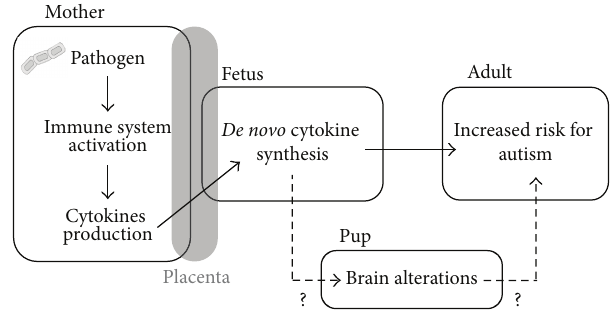
Figure 1: Association between prenatal infection and enhanced risk of neurodevelopmental disorders. During pregnancy, pathogens are thought to increase the risk of neurodevelopmental disorders in the offspring depending on the timing of infection and the magnitude of maternal immune response. Activation of the fetal immune system by de novo synthesis of cytokines sensitizes the brain to neu- rodevelopmental alterations. Interaction with other environmental and/or genetic factors also contributes to ASD etiology. Modeling prenatal immune activation represents a powerful tool to elucidate the relative contribution of these various factors for enhanced risk of ASD as well as other neurodevelopmental